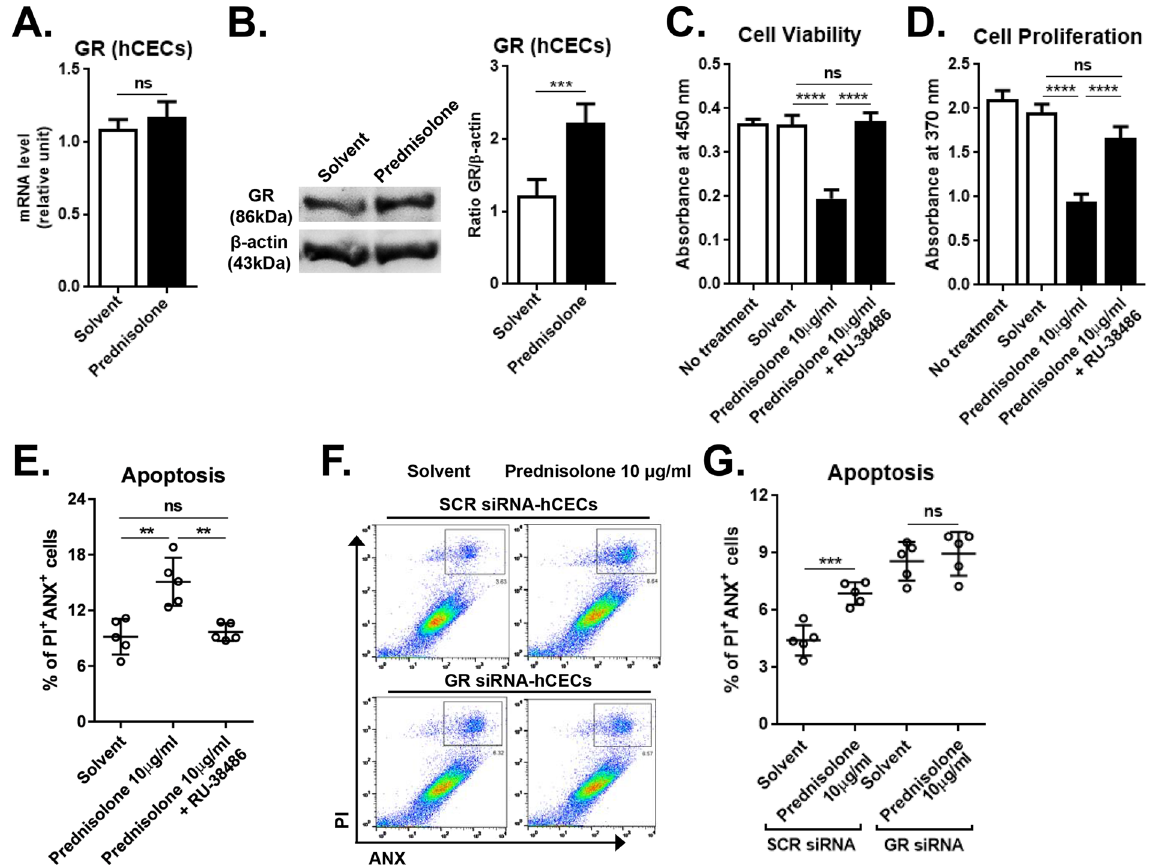
Figure 2. Glucocorticoid receptor (GR) mediates the effects of prednisolone. hCECs were cultured with or without 10 μ g/ml prednisolone for 3 days and subjected to assays. ( A ) Real-time RT PCR assay for GR expression. ( B ) Representative image and densitometry analysis of western blot for GR relative to β -actin. ( C , D ) MTT assay and BrdU uptake assay to measure cell metabolic activity and proliferation, respectively. ( E – G ) Flow cytometric analysis for ANX + PI + cells to measure cell apoptosis. The GR antagonist RU-38486 was added to some cultures ( E ). The percentage of ANX + PI + cells was measured in hCECs with GR siRNA or scrambled (SCR) siRNA transfection ( F , G ). Data are presented as mean ± / + SD from five independent sets of experiments including at least five samples per a set. ** p < 0.01, *** p < 0.001, **** p < 0.0001, ns: not